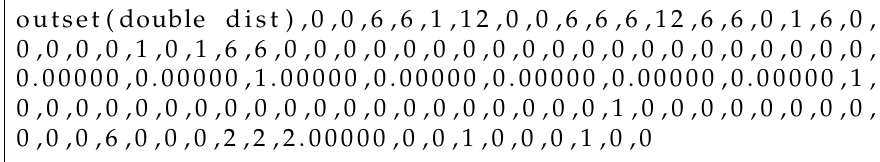
Figure 3. Example of the feature vector of a function outset(double dist) .